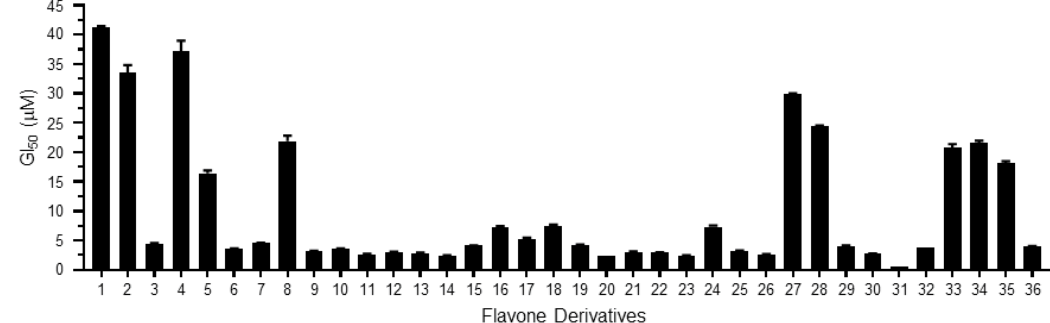
Figure 2. Half-maximal cell growth inhibitory concentration (GI 50 ) values in Table 1.